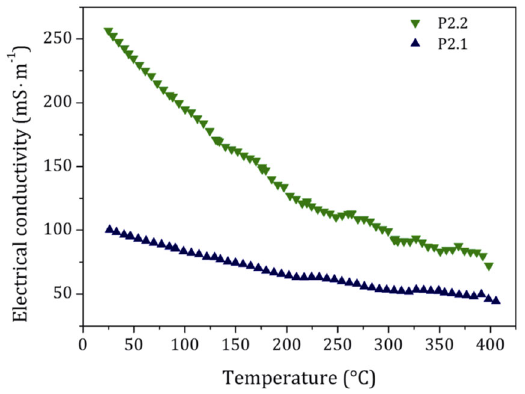
Fig. 8 Electrical conductivity vs. temperature of films formed from pastes P2.1 and P2.2 after 5 h sintering at 1400 ℃ .